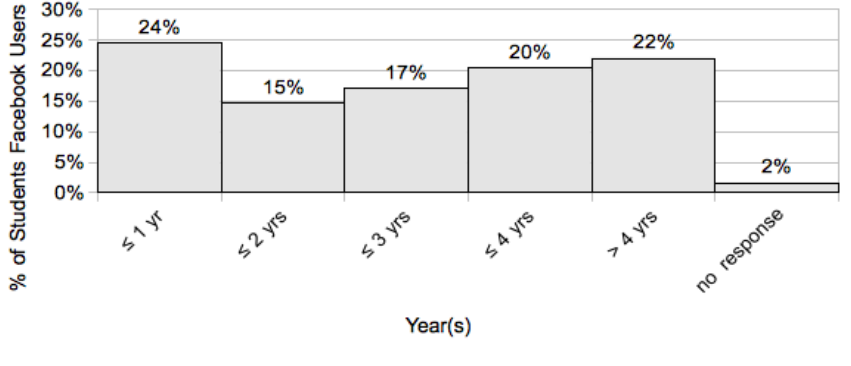
Figure 5. Duration of Facebook usage.